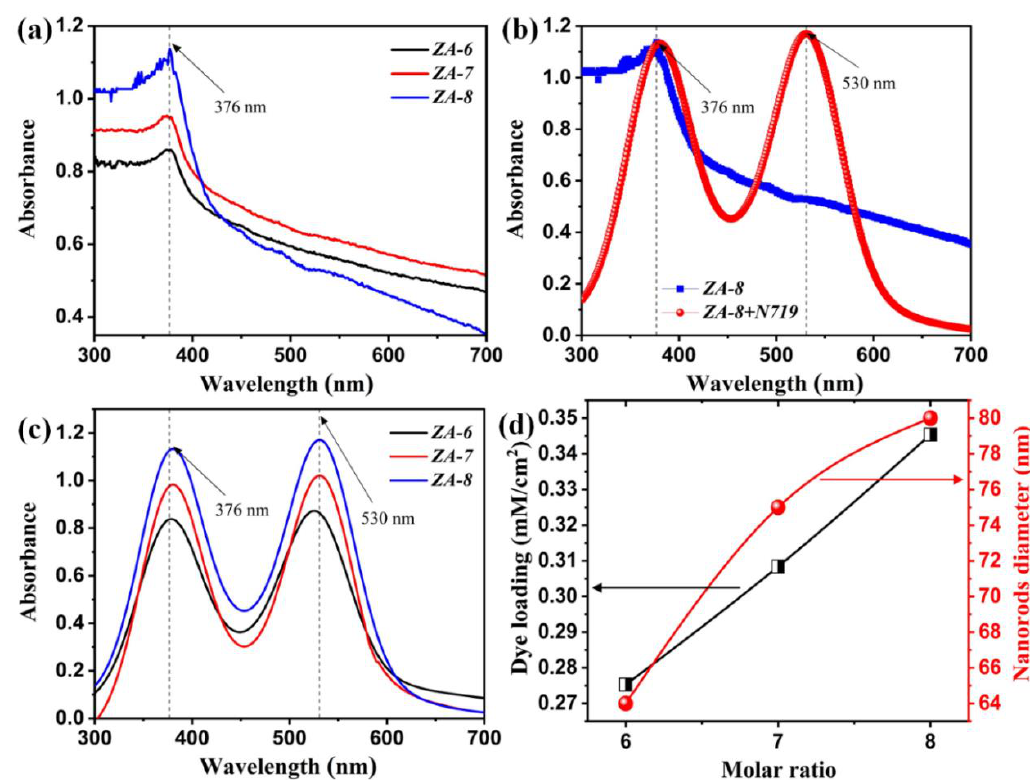
Figure 4. UV-Vis spectra of ( a ) ZA-m , ( b ) ZA-8 and ZA-8 containing N719, and ( c ) ZA-m containing N719, and ( d ) variation of the molar ratio vs. N719 loading and nanorods diameter.